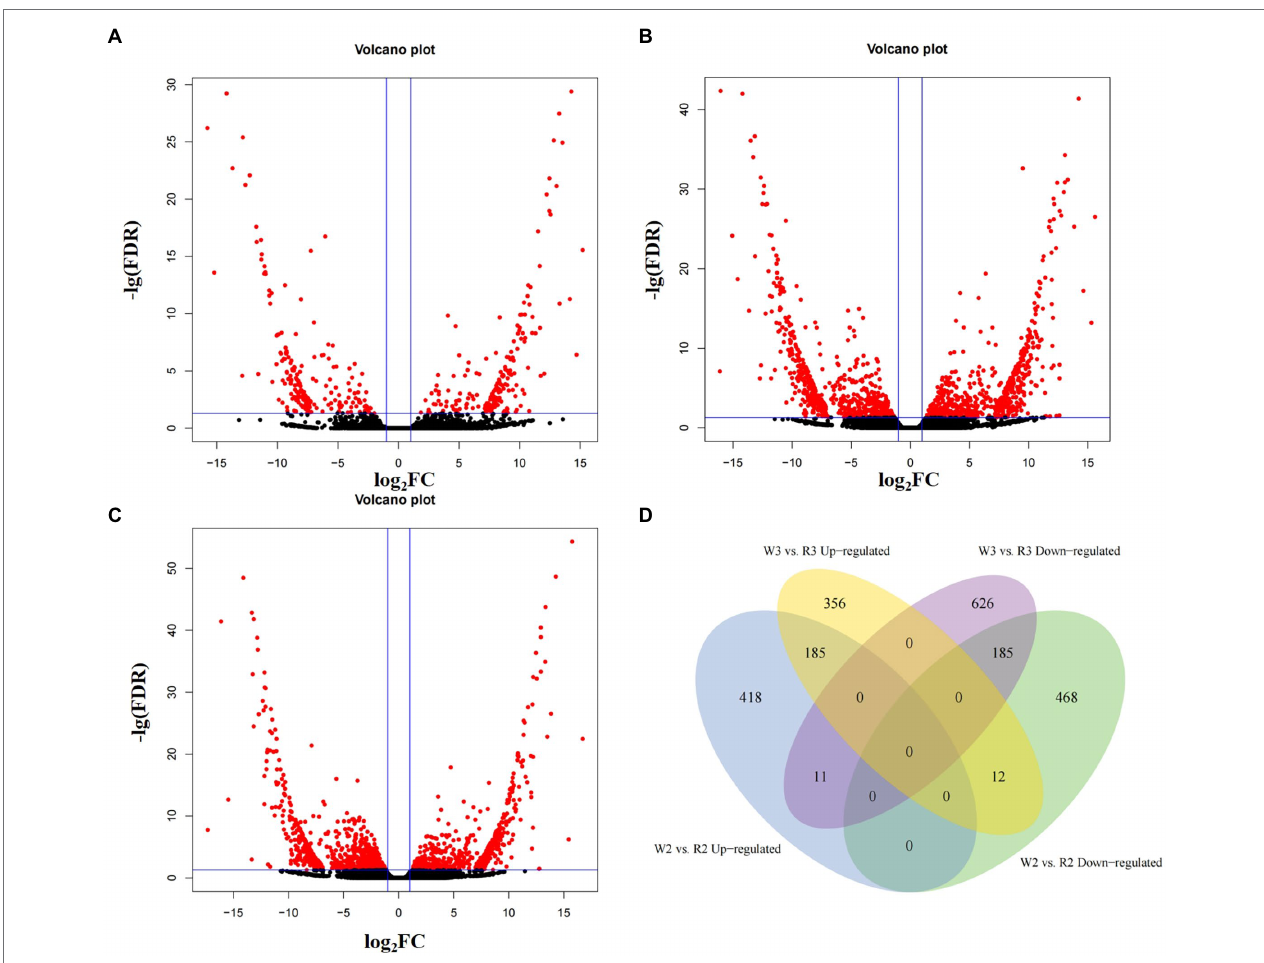
FIGURE 3 | Volcano plot and Venn diagram of differentially expressed genes at different stages between white (W) and red (R) flowers. (A) Early stage (W1, R1); (B) middle stage (W2, R2); (C) blooming stage (W3, R3); and (D) venn analysis of up- and down-regulated differentially expressed genes at middle and blooming